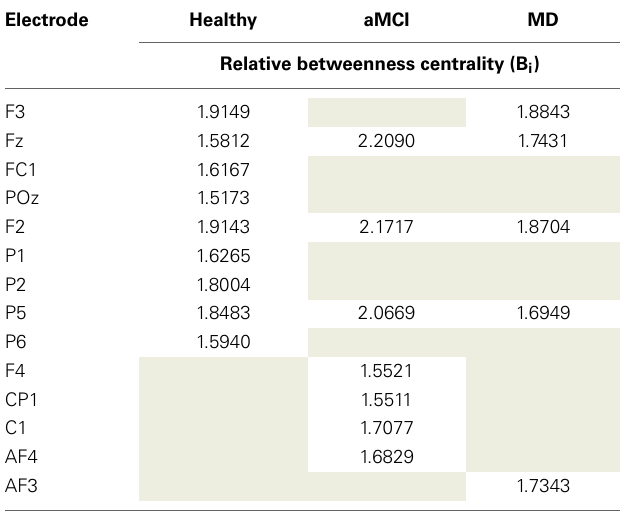
a significant main effect of group, F (2 , 61) = 5 . 87; p = 0 . 005.